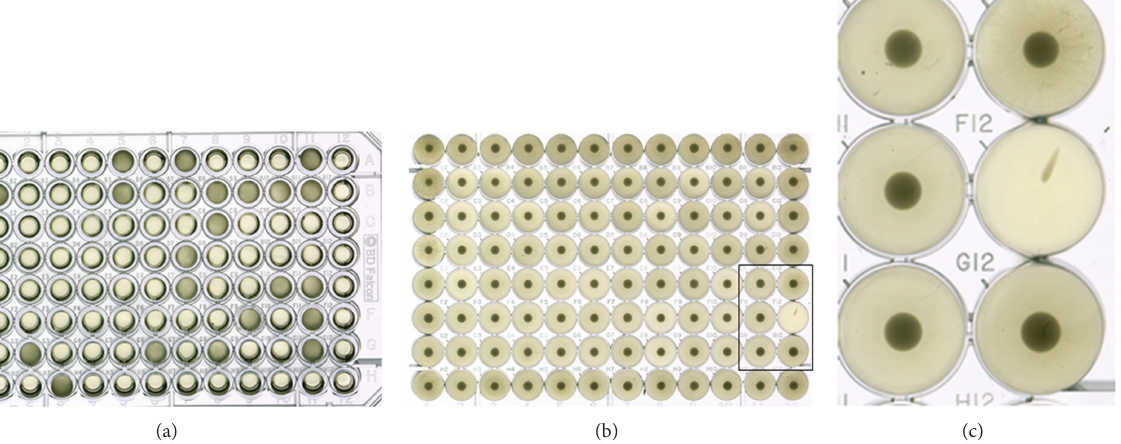
Figure 2: Screening A. oryzae culture supernatants for antibacterial activity. Fungal culture in 96 well plates allows visible confirmation of fungal growth. As seen in (a), wells with fungal growth are dark, while wells with no fungal growth contain only culture media and are comparativelyclear.ExaminationofU-bottom96wellplatebacterialculturessubjectedtofungalculturesupernatantsallowsvisualevaluation of reduction in MRSA bacterial growth (b). (c) a magnified area (boxed) of image in (b) clearly showing a single well with extremely reduced bacterial growth indicating antibacterial activity of fungal culture